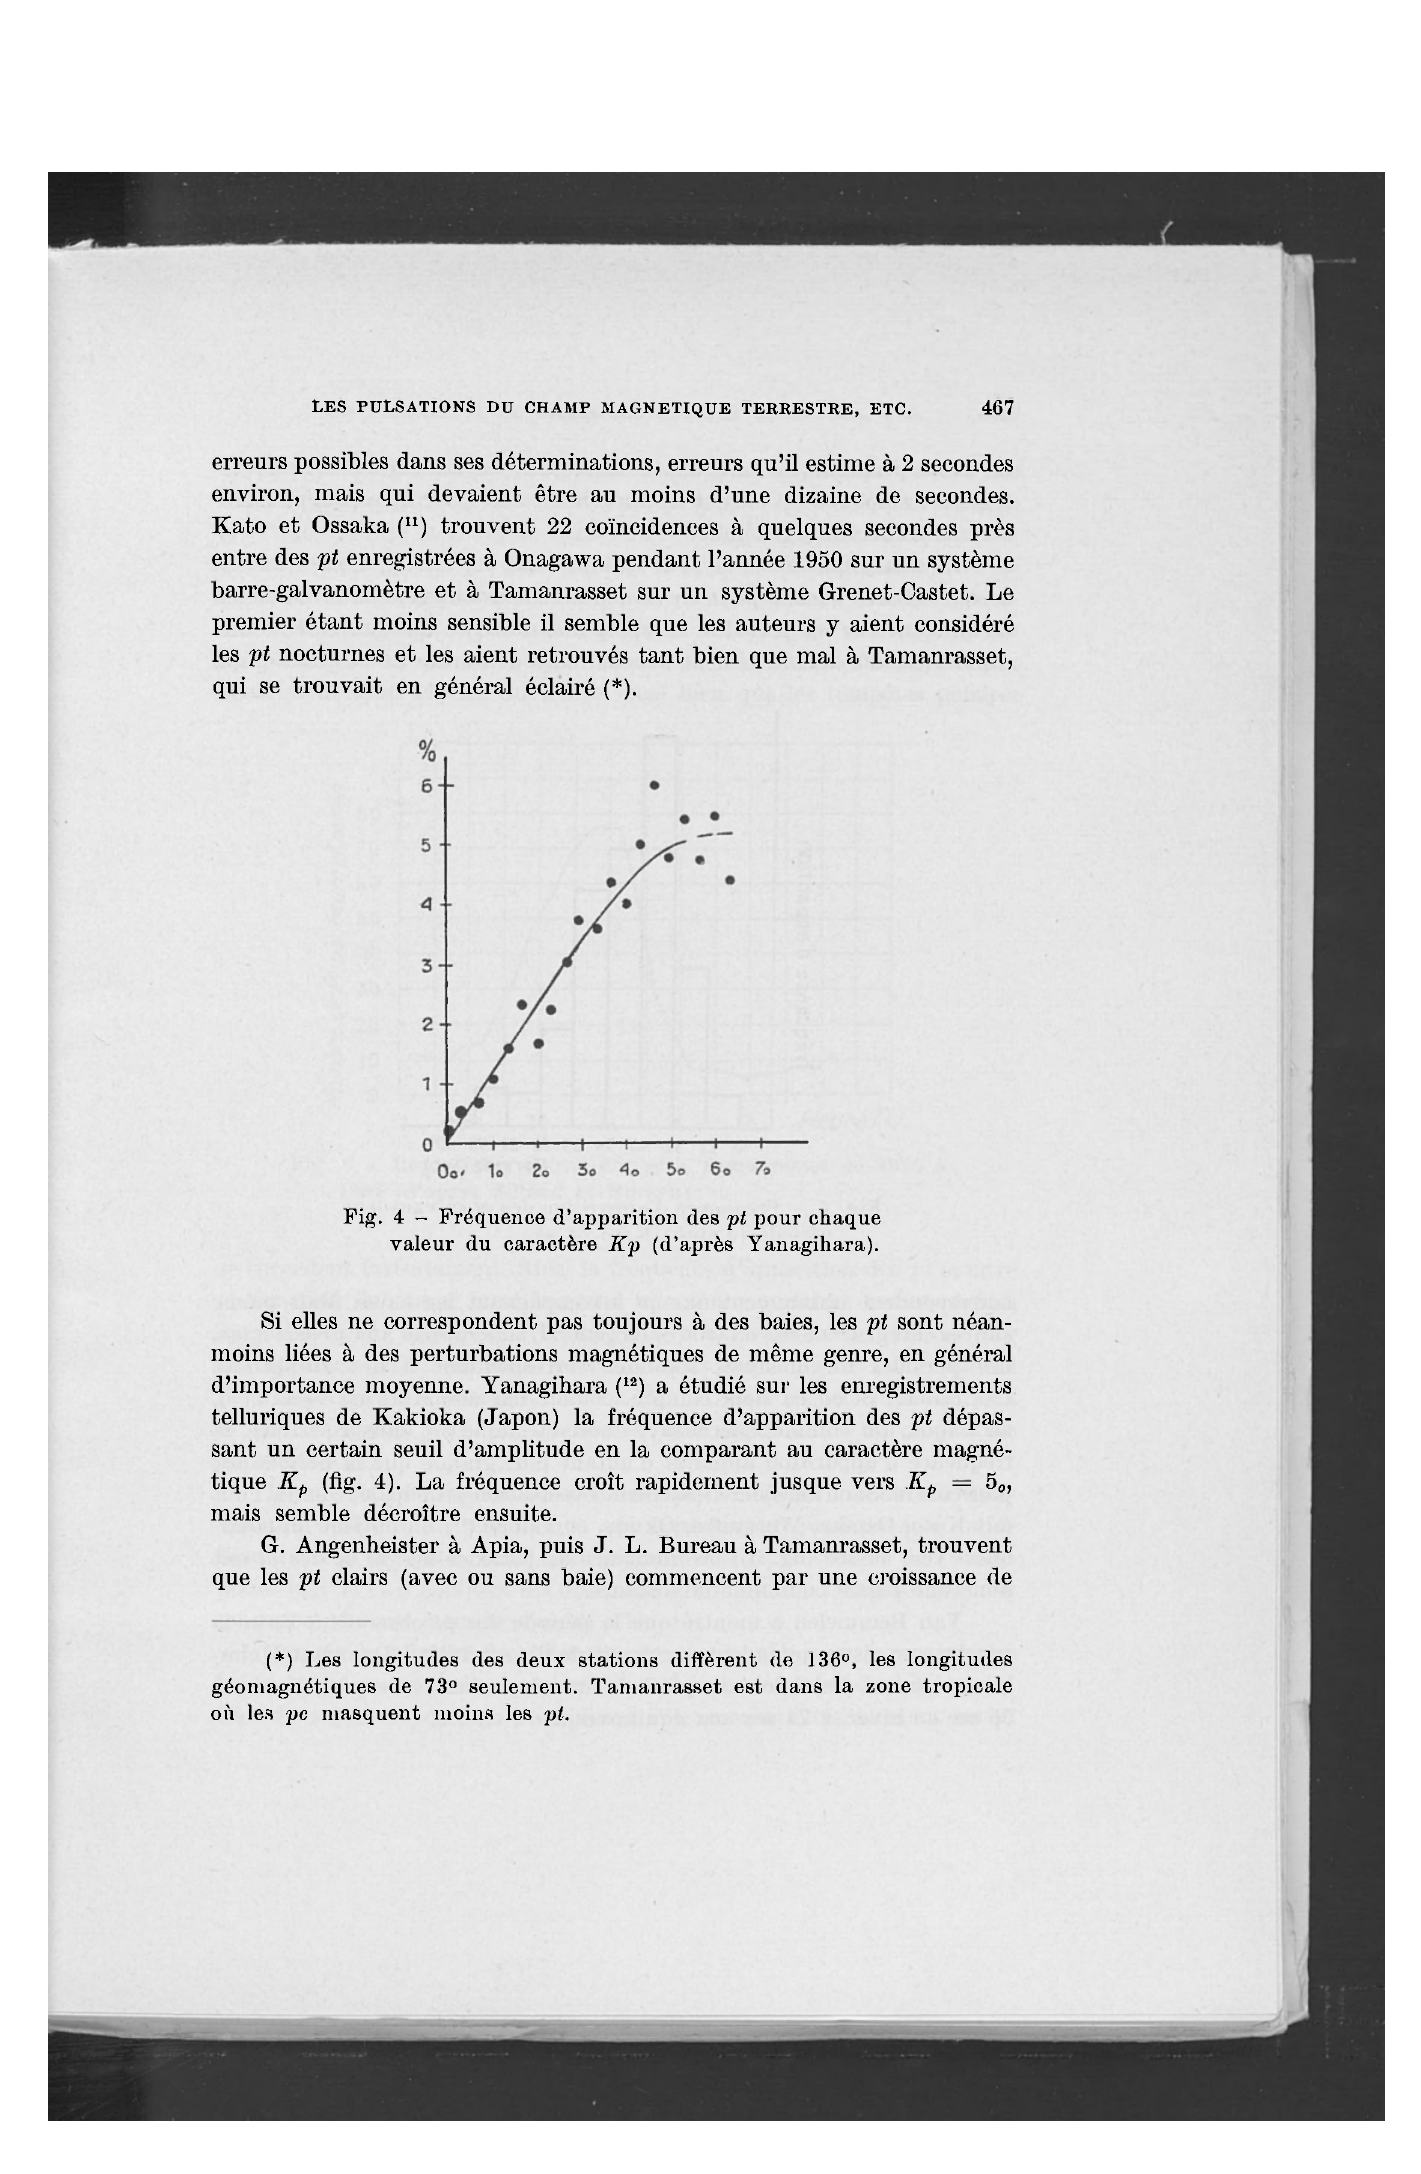
Fig. 4 - Fréquence d'apparition des pt pour chaque valeur du earaetère Kp (d'après